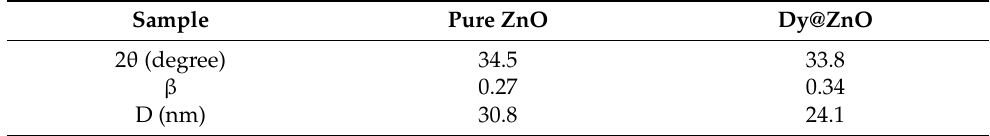
Table 2. Structural parameters of pure and Dy-doped ZnO thin films. Sample